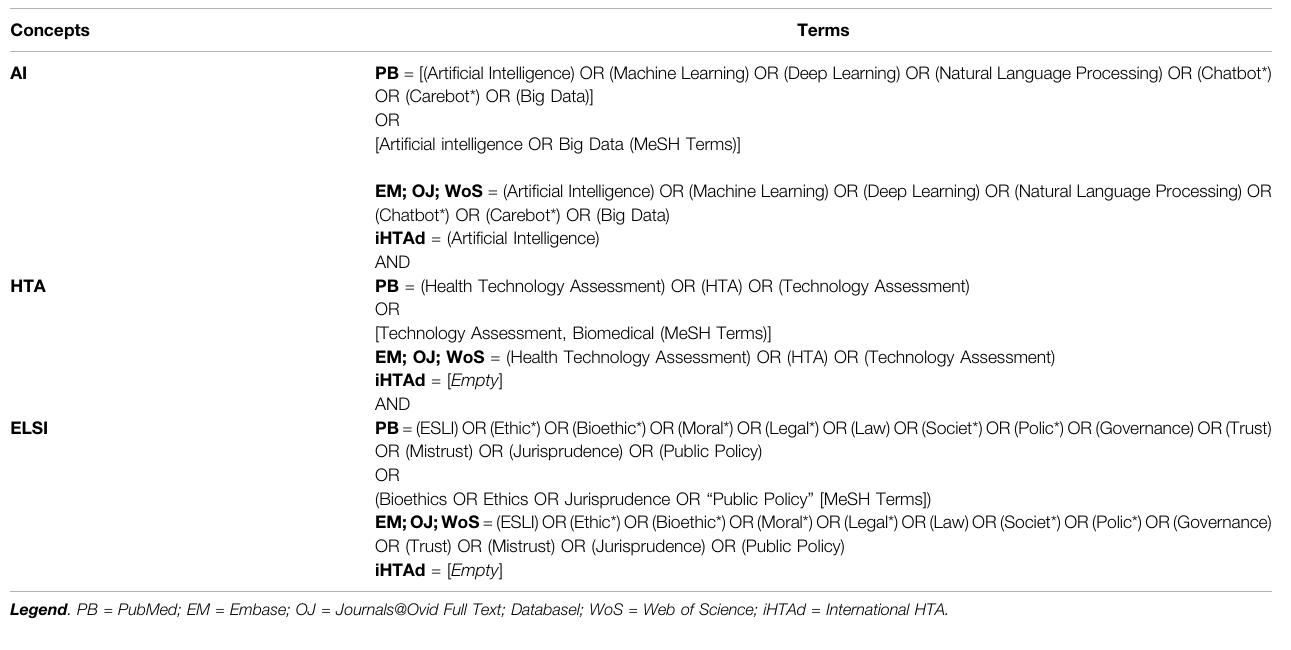
TABLE 1 | Search strategy.